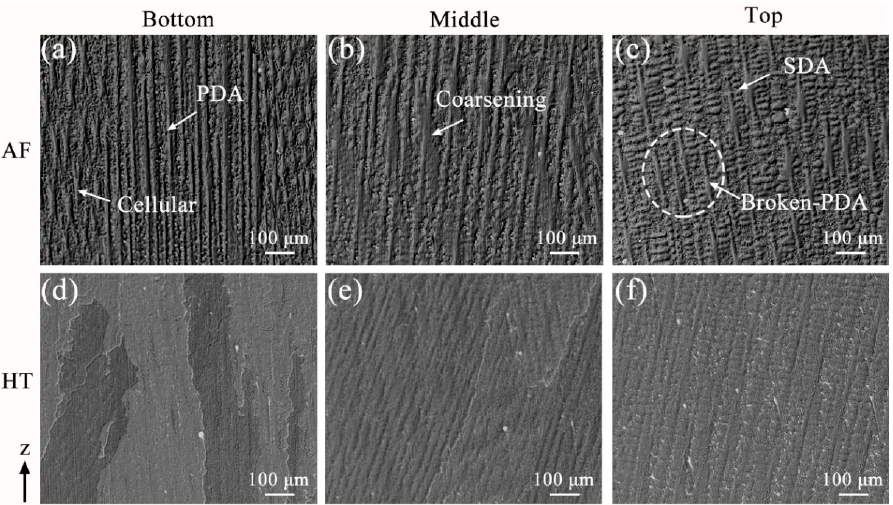
Figure 4. Optical micrographs of the microstructure of ( a – c ) as-fabricated (AF) samples and ( d – f ) heat- treated (HT) samples. heat-treated (HT)